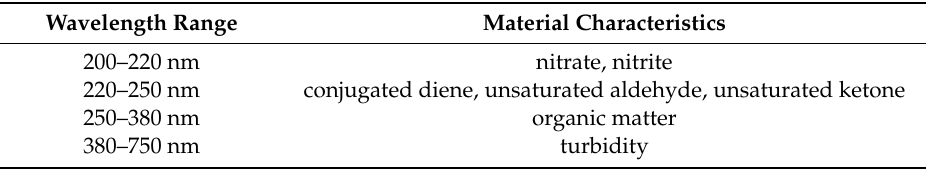
Table 1. Absorption spectrum range and substance characteristics of various